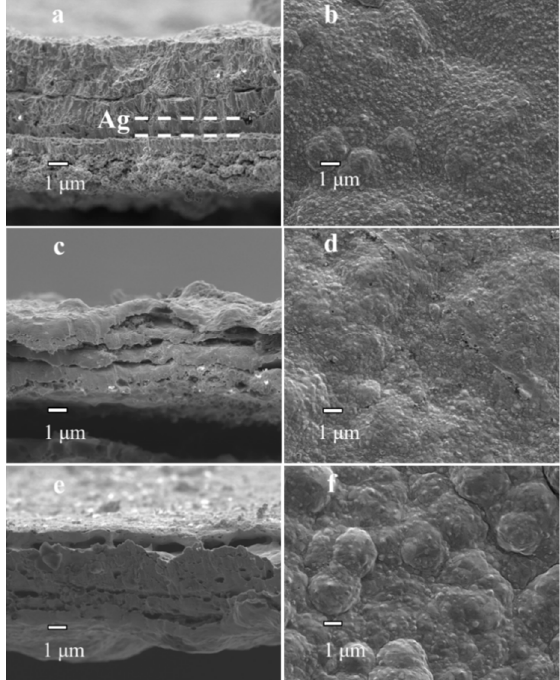
Figure 4. SEM images of Pd-Ag alloy layers: ( a , b ) PAP-1 before alloying, ( c , d ) PAP-1 after alloying under hydrogen at 823 K for 24 h and ( e , f ) PAP-2 after alloying under nitrogen at 823 K for 24 h.